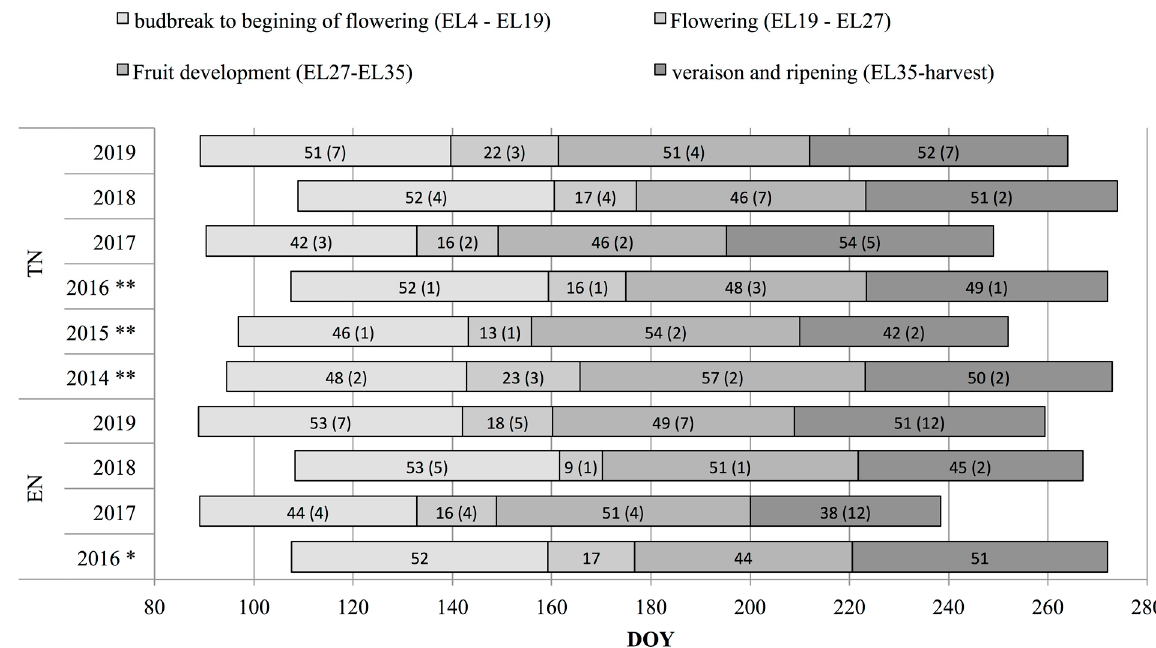
Figure 3. Phenological development and mean duration of the main phenophases of cv. Touriga Nacional (TN) and Encruzado (EN) in each year, between 2014 and 2019. The number within parenthesis is the standard deviation among plots. * (**) refers to years that include phenological observations only from plot VP1 (VP1 and VP2).